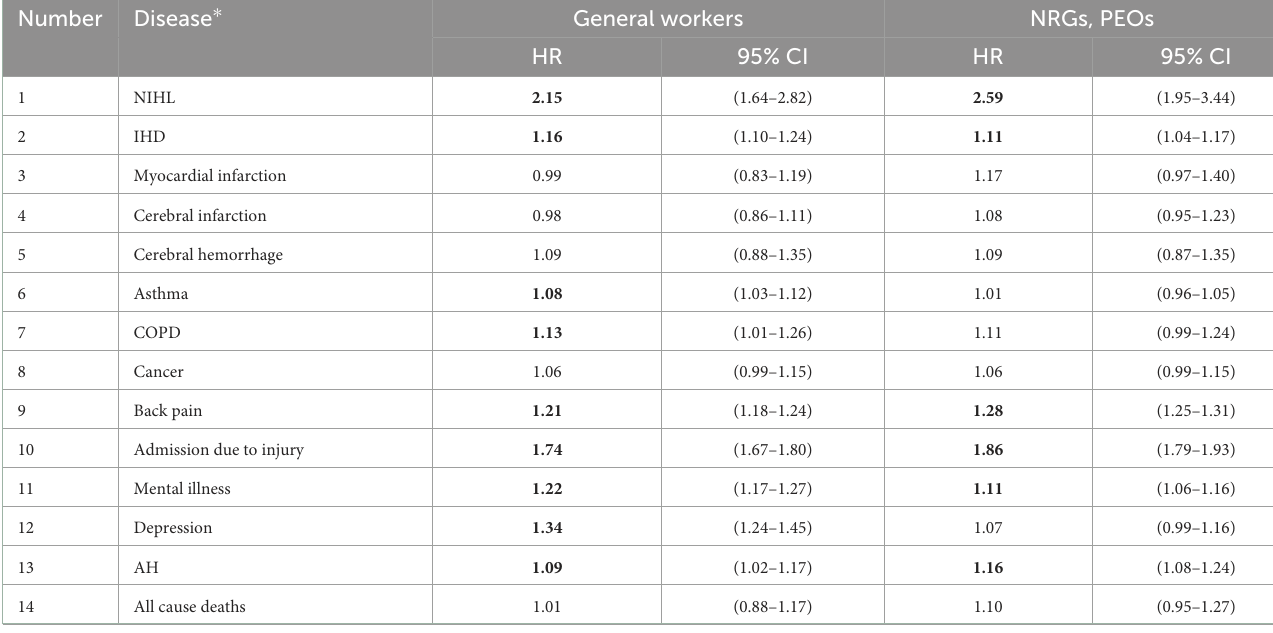
TABLE 4 Hazard ratios and 95% confidence intervals for the risk of death from all causes and risk of diseases for firefighters compared to general workers, national regional government officers, and public educational officers after propensity score